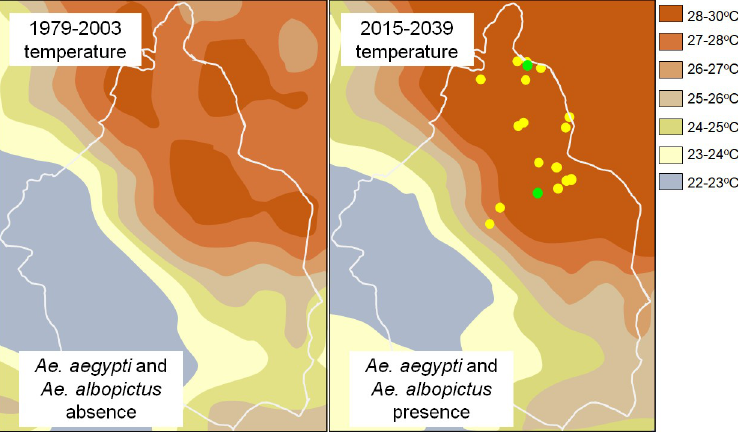
Fig 4. Possible correlation between the projected increase in temperatures (modified from [20]) and the current presence of Ae . aegypti (yellow dots) and Ae . albopictus (green dots) in the city.